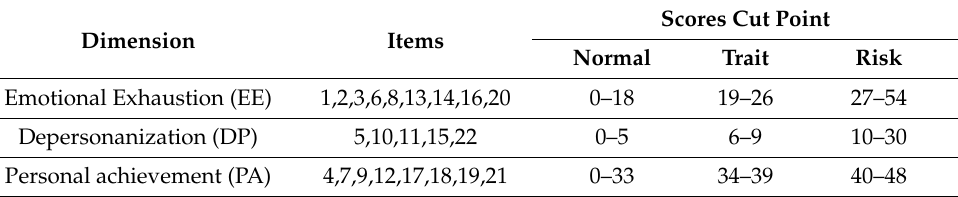
Table 1. MBI-HSS cut